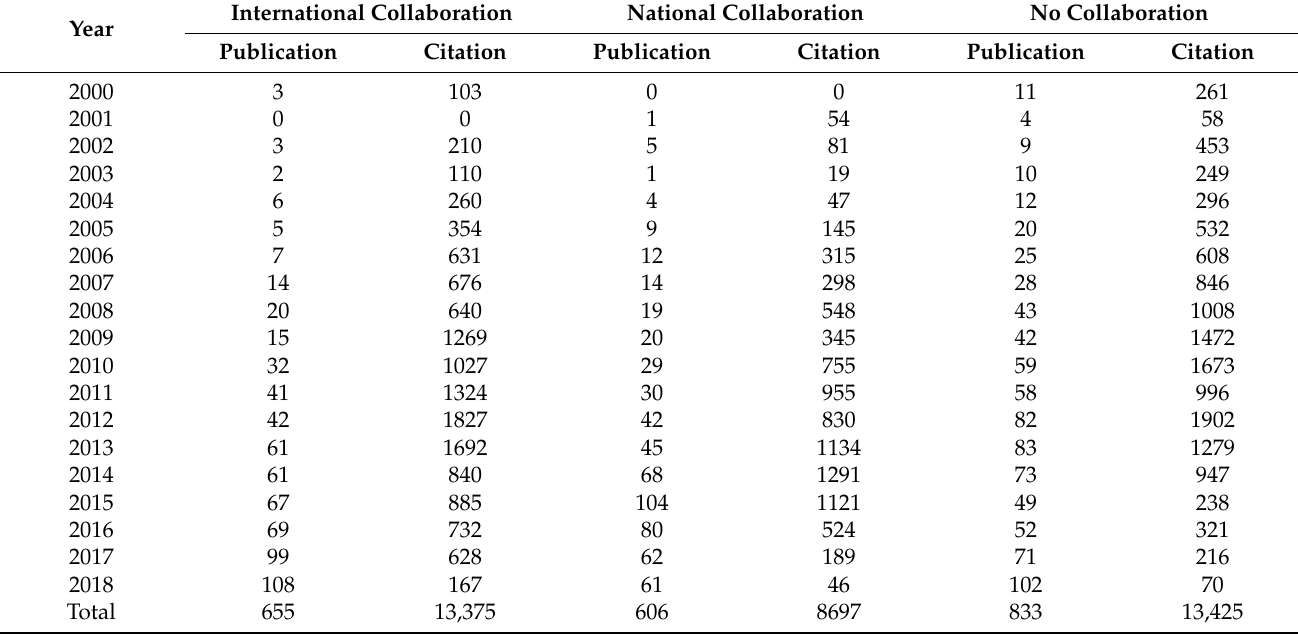
Table 1. Frequency of publications and citations based on collaborations.